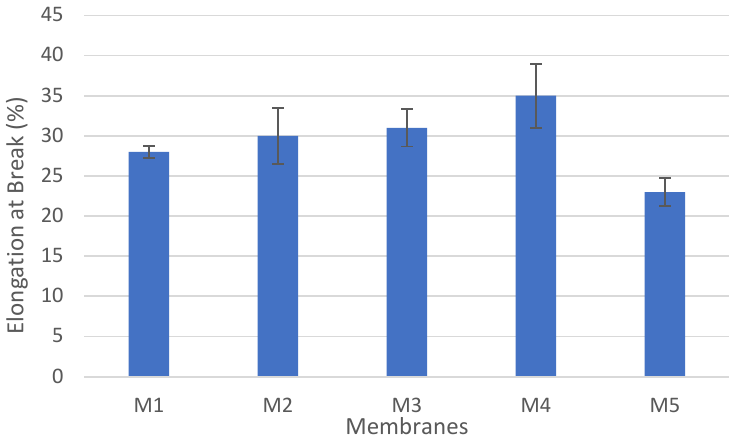
Figure 14. Elongation at break for cast PSF membranes.